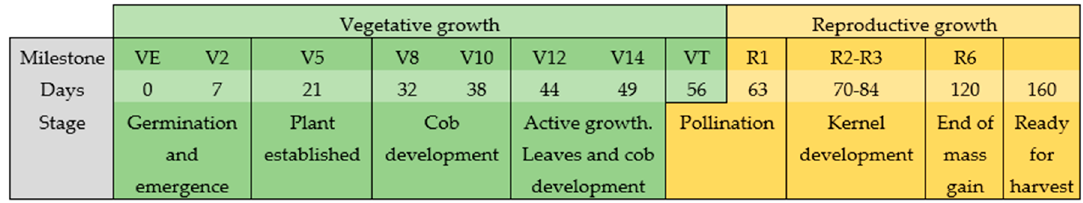
Figure 27. Conceptual Model – Plant’s daily nitrogen need.